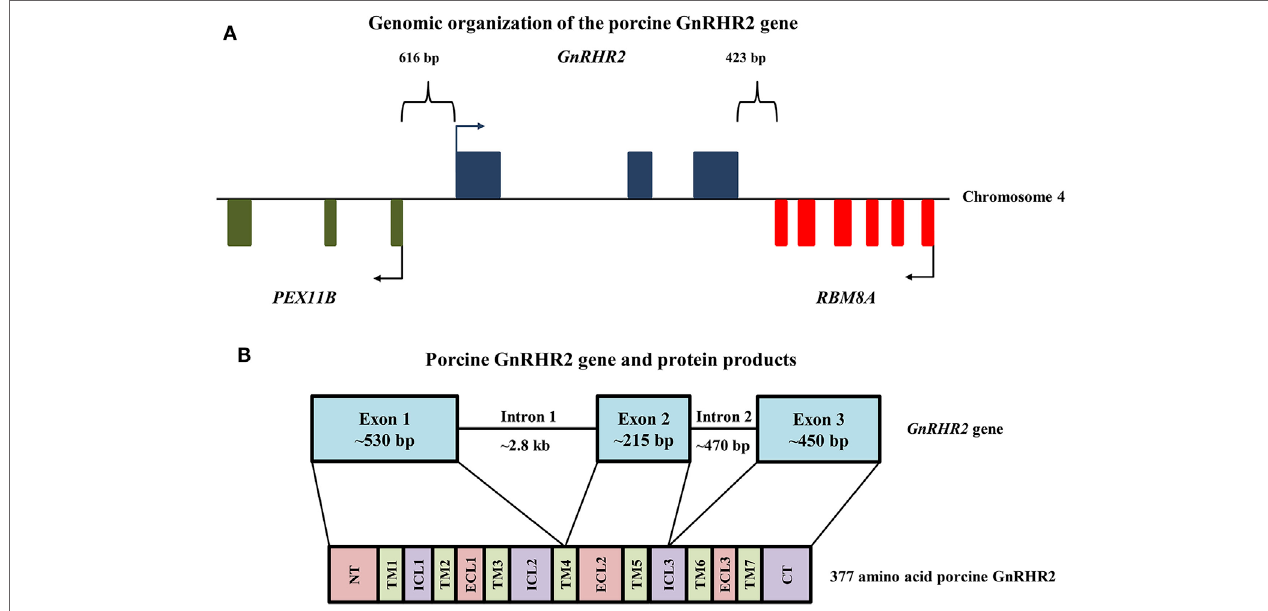
FiGURe 2 | Genomic organization of the porcine GnRHR2 gene on chromosome 4. (A) The PEX11B gene (green) is located 616 bp upstream, whereas the RBM8A gene (red) is positioned 423 bp downstream of the GnRHR2 gene (blue). Arrows indicate start codons for each gene. Reprinted from Brauer et al. (75) with permission from Elsevier. (B) The GnRHR2 gene contains 3 coding exons and 2 introns, yielding a 377 amino acid product. Exon 1 of the porcine GnRHR2 gene encodes the extracellular N-terminus (NT), transmembrane (TM) domains 1–3, part of TM4, intracellular loops (ICL) 1–2 and extracellular loop (ECL) 1. Exon 2 encodes the remainder of TM4 as well as TM5, ECL2, and part of ICL3. Exon 3 encodes the remainder of ICL3, TM domains 6–7, ECL3, and the C-terminal tail (CT). Note that introns and exons are not drawn to